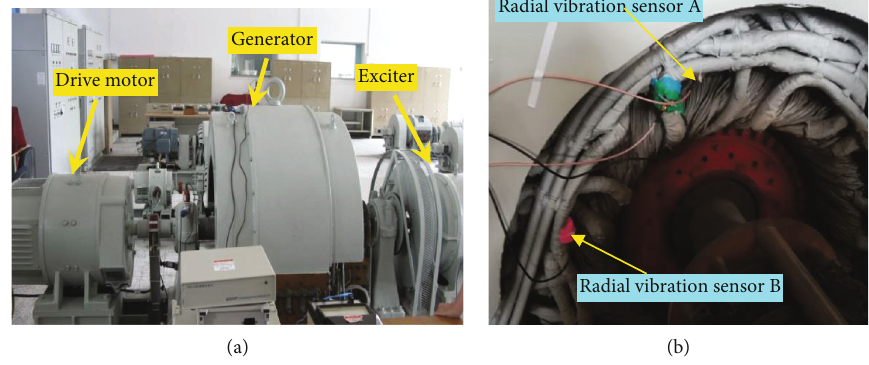
Figure 9: Fault simulating generator: (a) general outlook and (b) vibration sensor settings. Table 2: Key parameters of the MJF-30-6 prototype